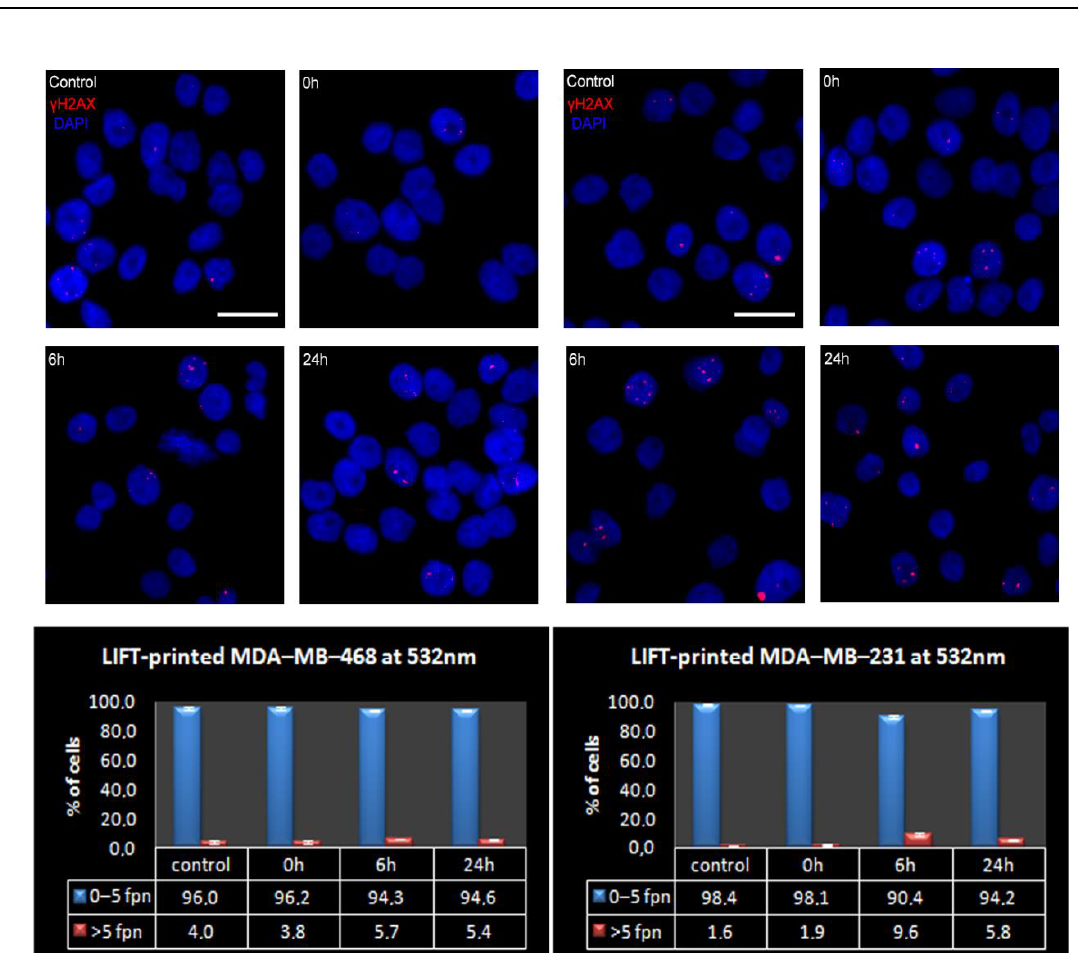
Figure 8. Presence of γH2AX foci on LIFT -printed breast cancer cells at 532 nm (MDA-MB-468 on the left and MDA-MB-231 on the right). ( Top ) Representative IF images of γH2AX foci on control or printed cells at the indicated timepoints. Cell nuclei were counterstained with DAPI, scale bar = 20 μm. ( Bottom ) The percentage of high- and low-DSB-bearing populations at control or given time points after LIFT-printing, fpn-foci per nucleus. The measurements obtained from at least 3 inde- pendent experiments and the total cells analyzed were: for MDA-MB-468 control = 1221, 0 h = 1705, 6 h = 1584, 24 h = 1456 and for MDA-MB-231 control = 1609, 0 h = 1896, 6 h = 1769, 24 h = 1746.